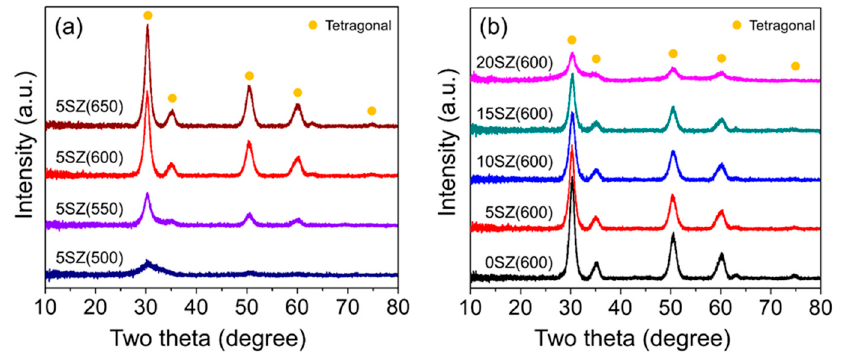
Figure 1. XRD patterns of ( a ) 5SZ( y ) and ( b ) x SZ(600) catalysts prepared by using different calcination temperatures and the sulfate contents, respectively. Table 1. Physicochemical properties of x SZ( y ) catalysts.